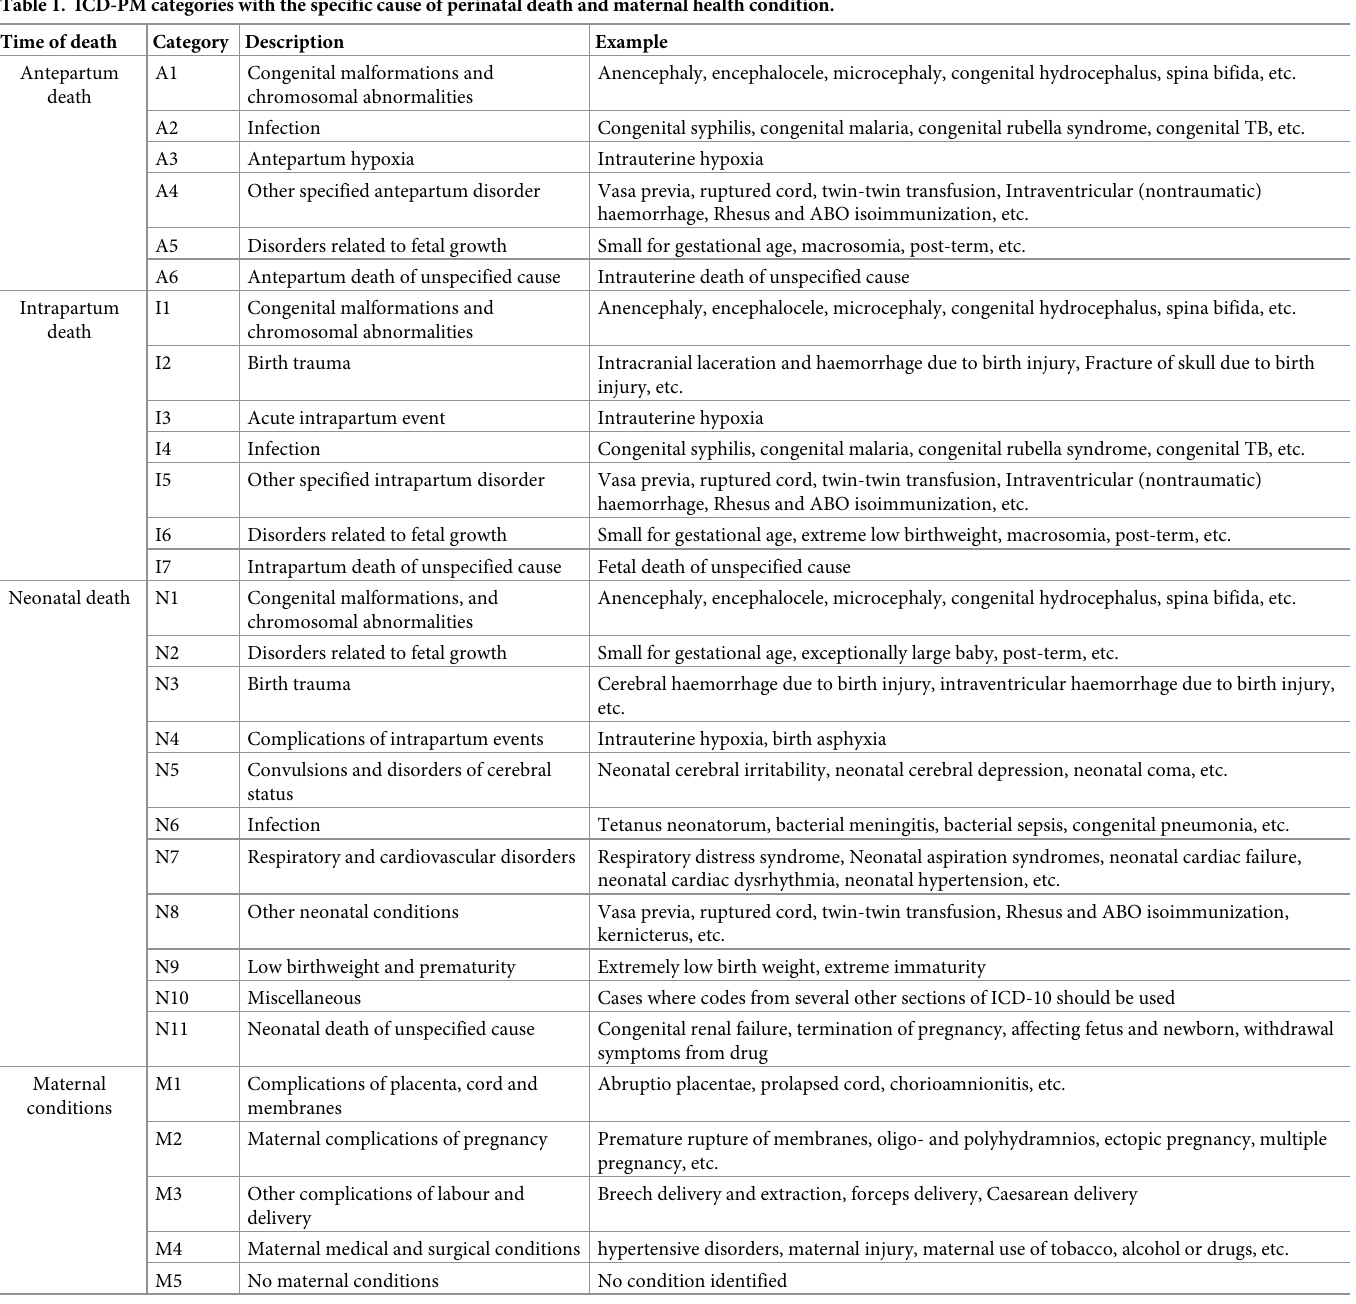
Table 1. ICD-PM categories with the specific cause of perinatal death and maternal health condition. Time of